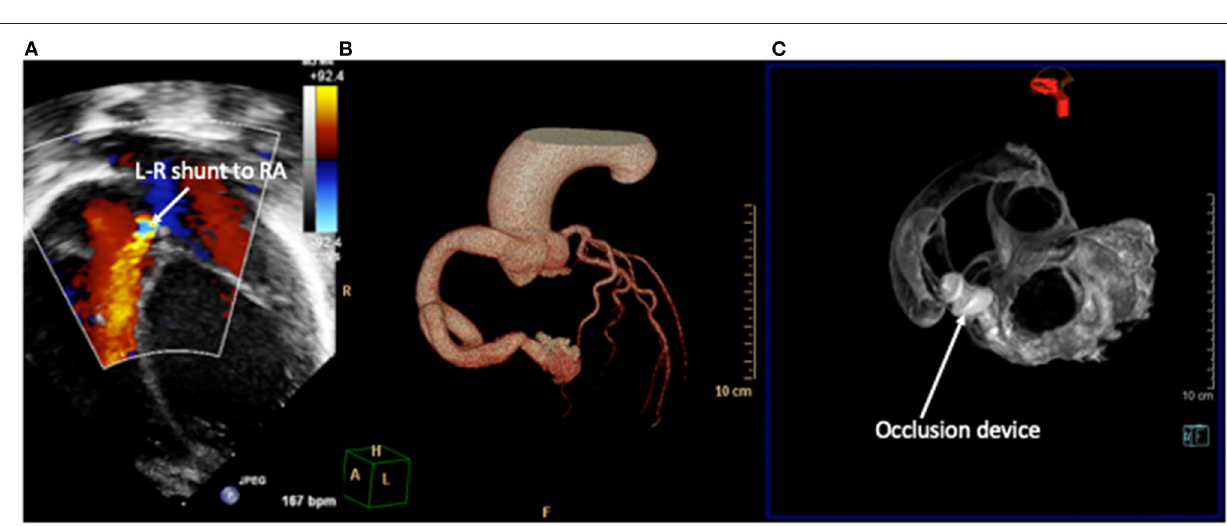
FIGURE 6 | Right coronary artery fistula to right atrium (RA). (A) 2D echocardiography with color Doppler demonstrates the drainage point of the fistula into the RA at high velocity. Images courtesy of Israel Valverde, King’s College London. The course of the fistula is better defined on contrast-enhanced CT (B) which allows for simulation of device occlusion as shown in a rotational CT image in image (C)